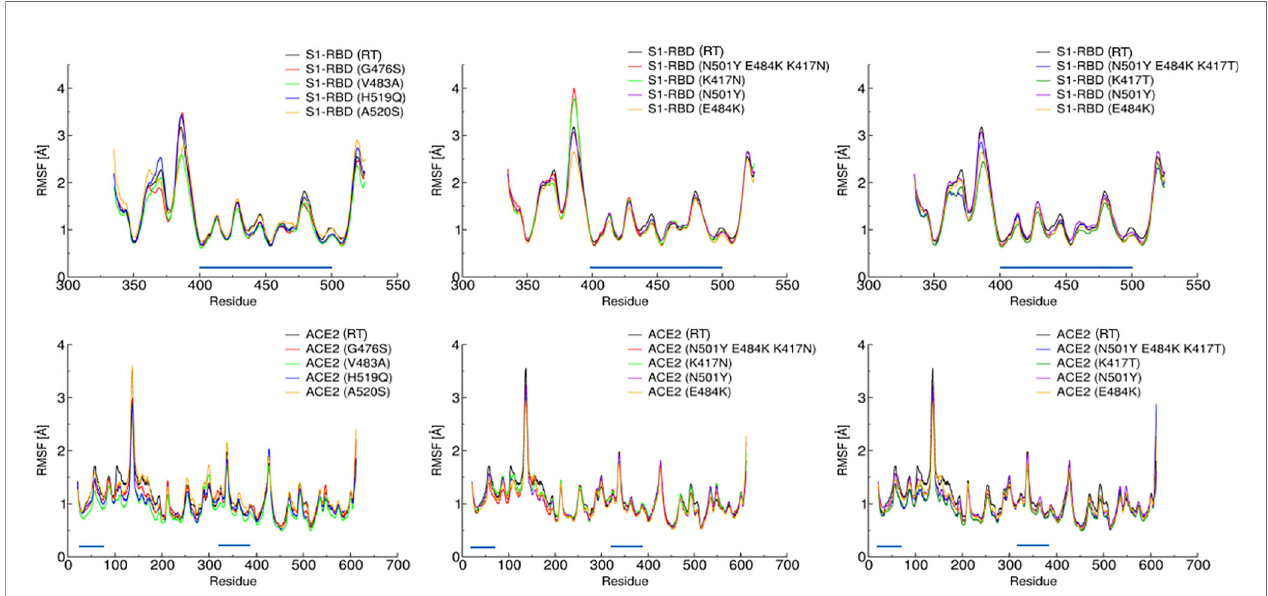
FIGURE 2 | Root Mean Square Fluctuation of the S-RBD variants (top panels) and hACE2 receptor (bottom panels) vs. residue index. The graphs are divided into three different panels for better readability. Amino acids belonging to the contact region are indicated by a blue line parallel to the x-axis. A direct comparison between the various trajectories reveals that the dynamic behavior of the complex S-RBD/hACE2 is not signi fi cantly affected by these mutations.